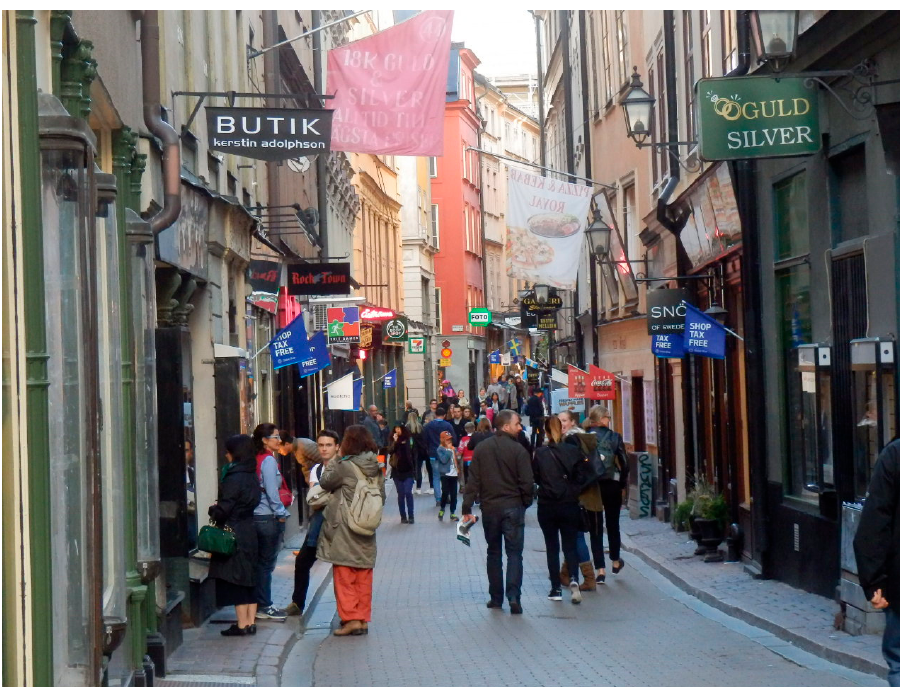
Figure 26. Stockholm’s old, dense, mixed use inner city based on tunnelbana, surface trams, walking, and cycling. Source: Jeffrey Kenworthy.